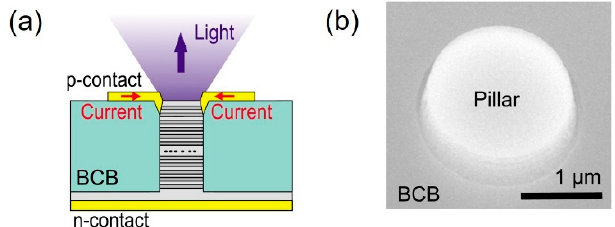
Figure 2. Current injection micropillar lasers. ( a ) Schematic of the electrically driven quantum dot (QD)-micropillar laser structure (left). The cavity layer where QDs are located is sandwiched by top and bottom distributed Bragg reflector structures. Vertical micropillar structures are planarized with benzocyclobutene (BCB), which electrically isolates the top and bottom contacts. ( b ) Scanning electron microscope (SEM) image of InGaAs QD micropillar before definition of metallic p -contact [17]. Figure reproduced with permission from American Institute of Physics.